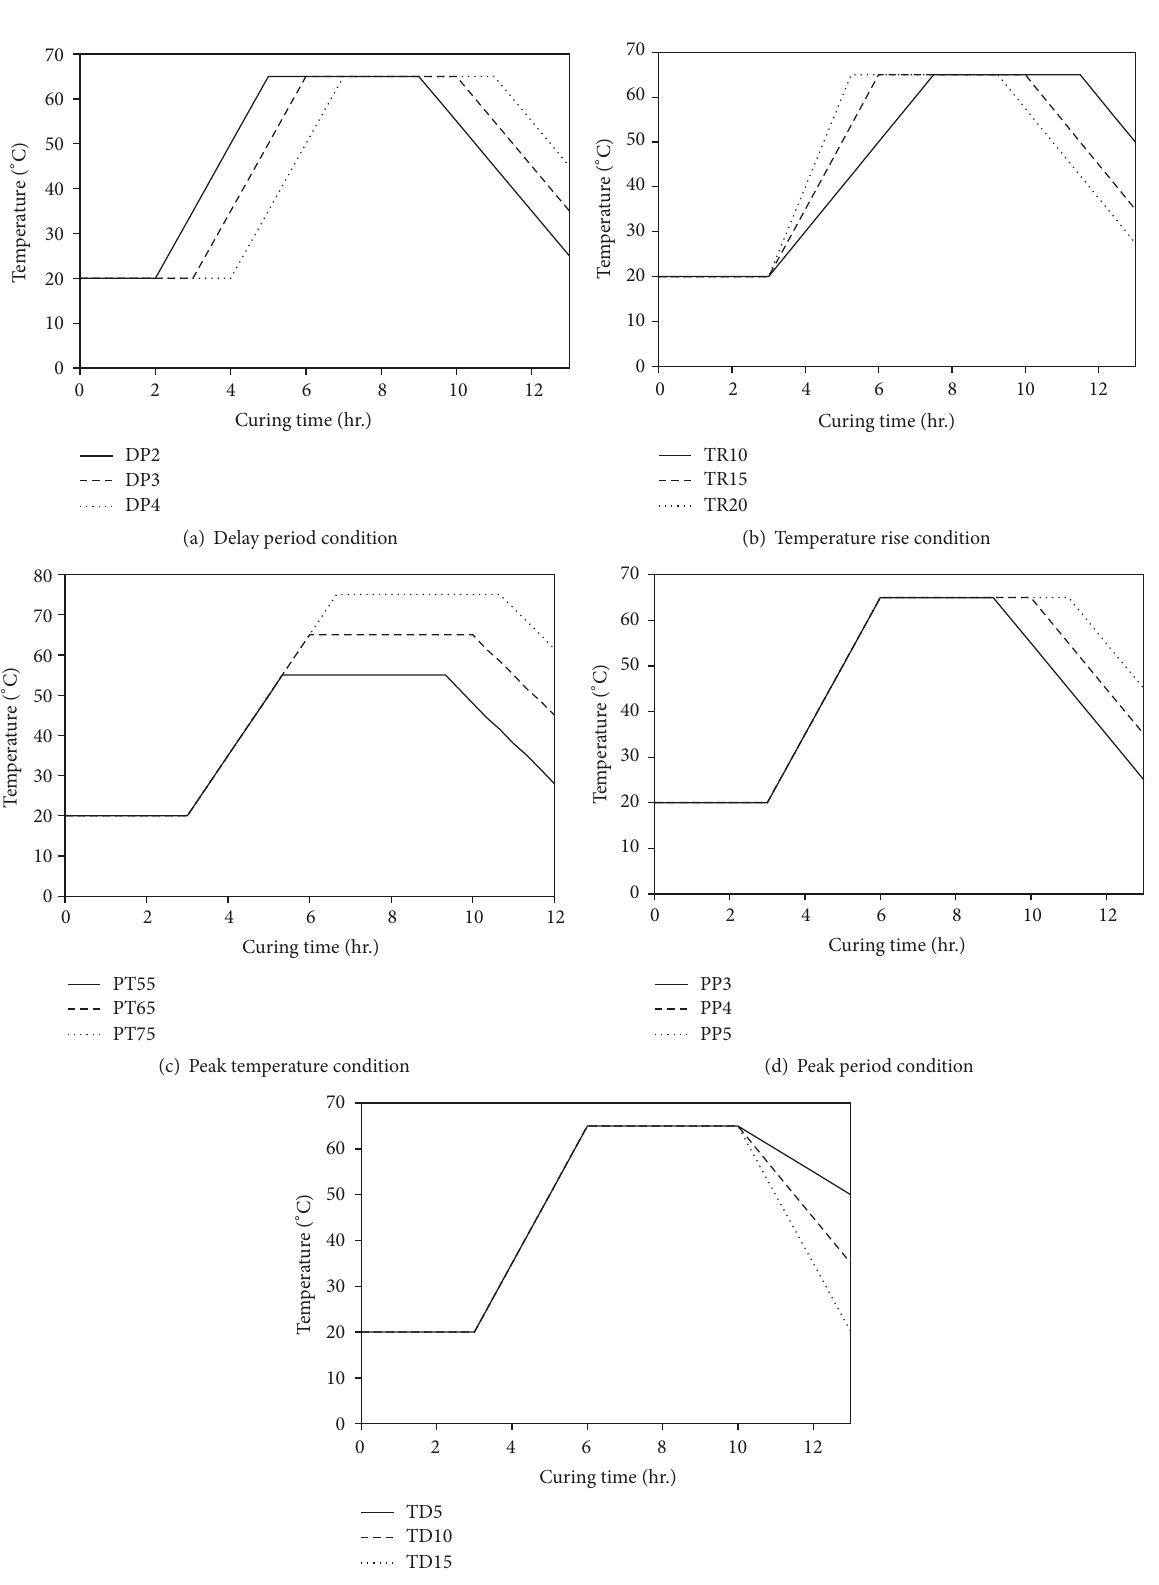
Figure 3: Various high-temperature curing methods used in this